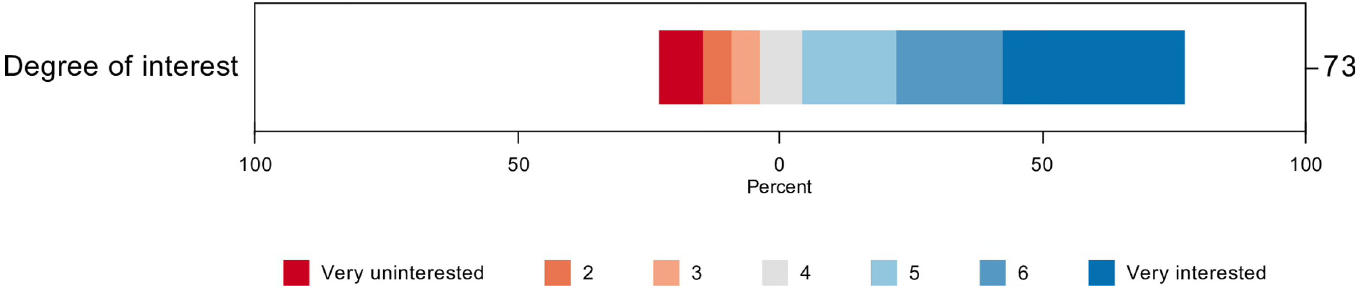
Fig 3. Level of research interest by professions.